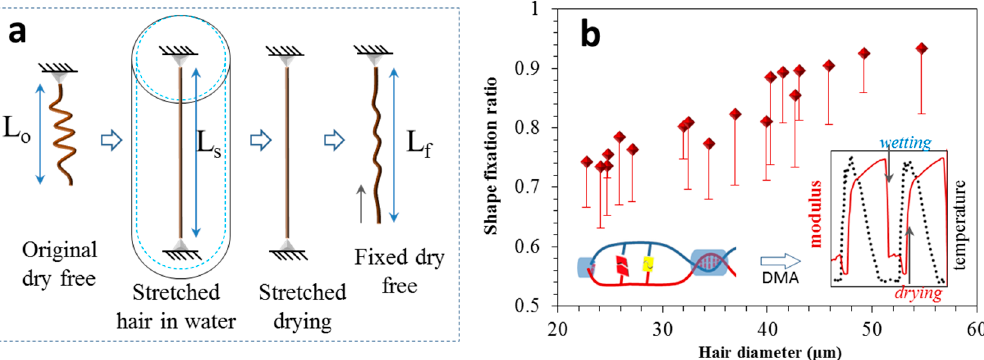
Figure 5. A quantitative shape fixation test of yak hair, ( a ) test principle with four steps (original length (L o ) → length of stretched hair in water (L s ) → fixed length of hair after drying process (L f )), ( b ) the measured shape fixation ratios related to hair diameter, where the inset refers to our previous publication [18] that wetting can reduce the hair storage modulus by opening the hydrogen bonds in hair amorphous area and drying process shows the reverse function. The inset figure in ( b ) is reproduced from [18] under open access license.